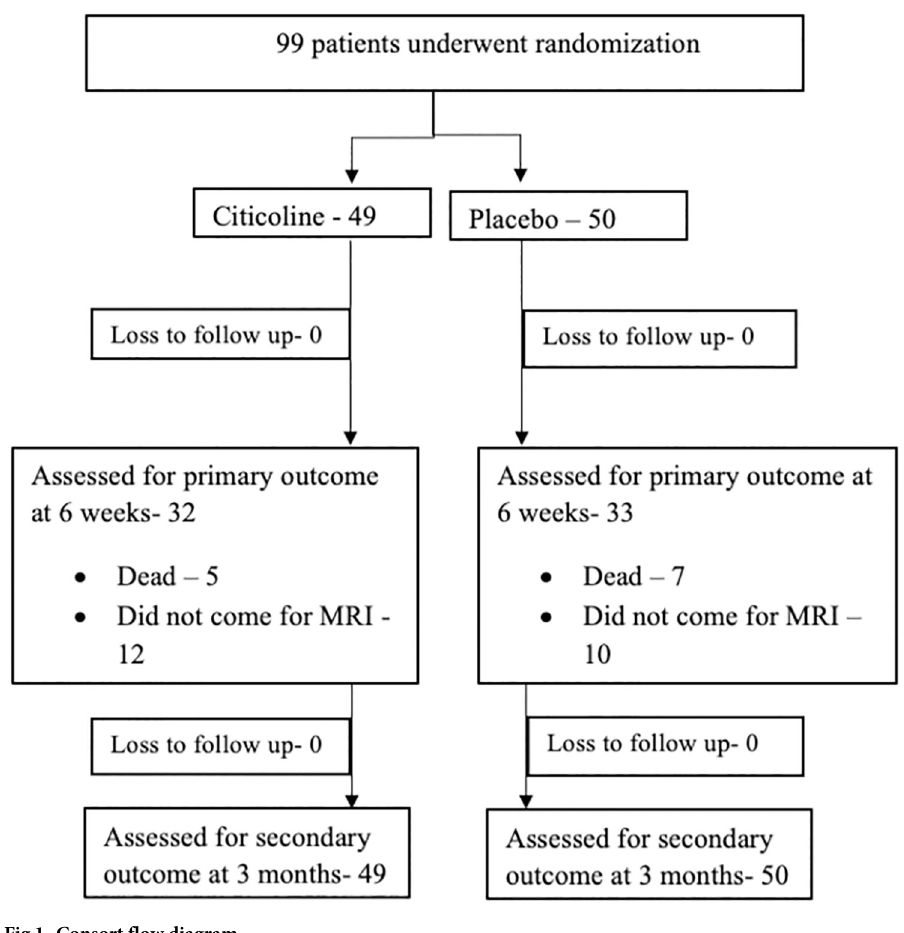
Fig 1. Consort flow